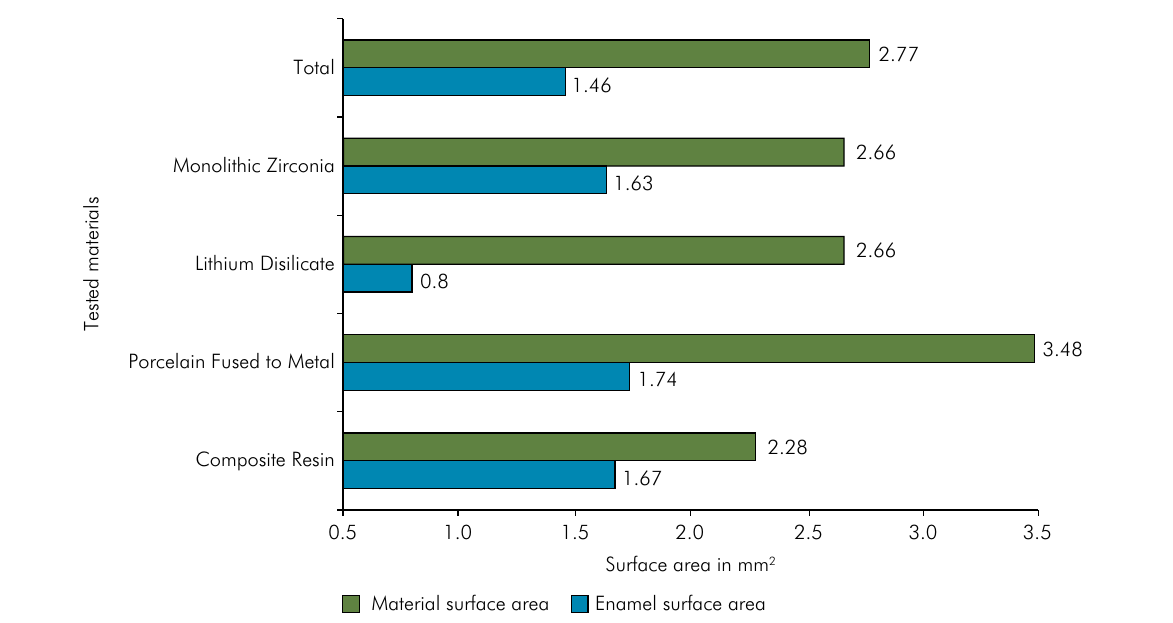
Figure 5. Graphical comparison of mean surface area of enamel and